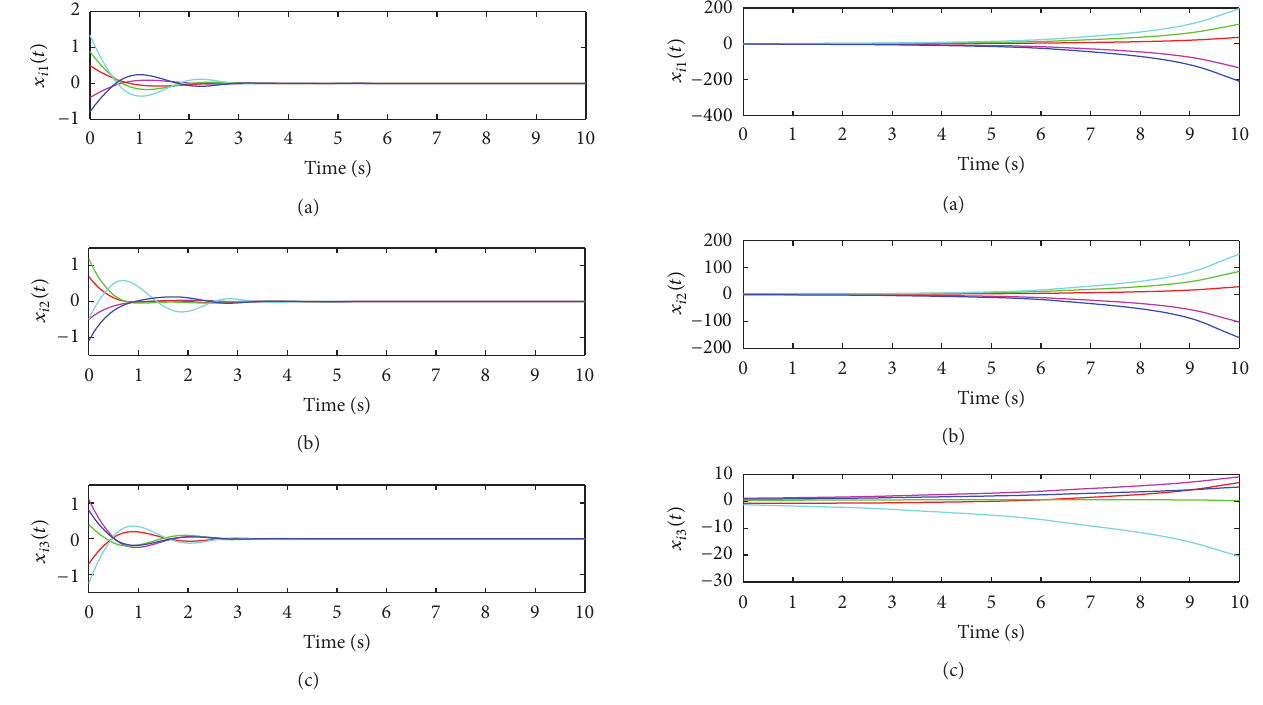
Figure 3: Synchronization state curves for the synchronizable subnetwork (69).